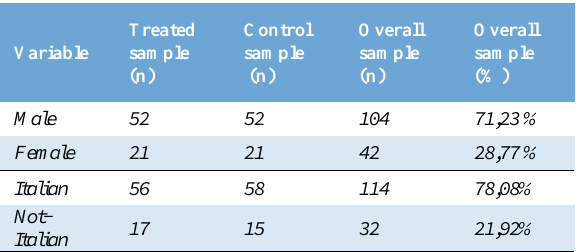
Table 1. Percentage of PhDs according to their gender and nationality Treated Variable sample